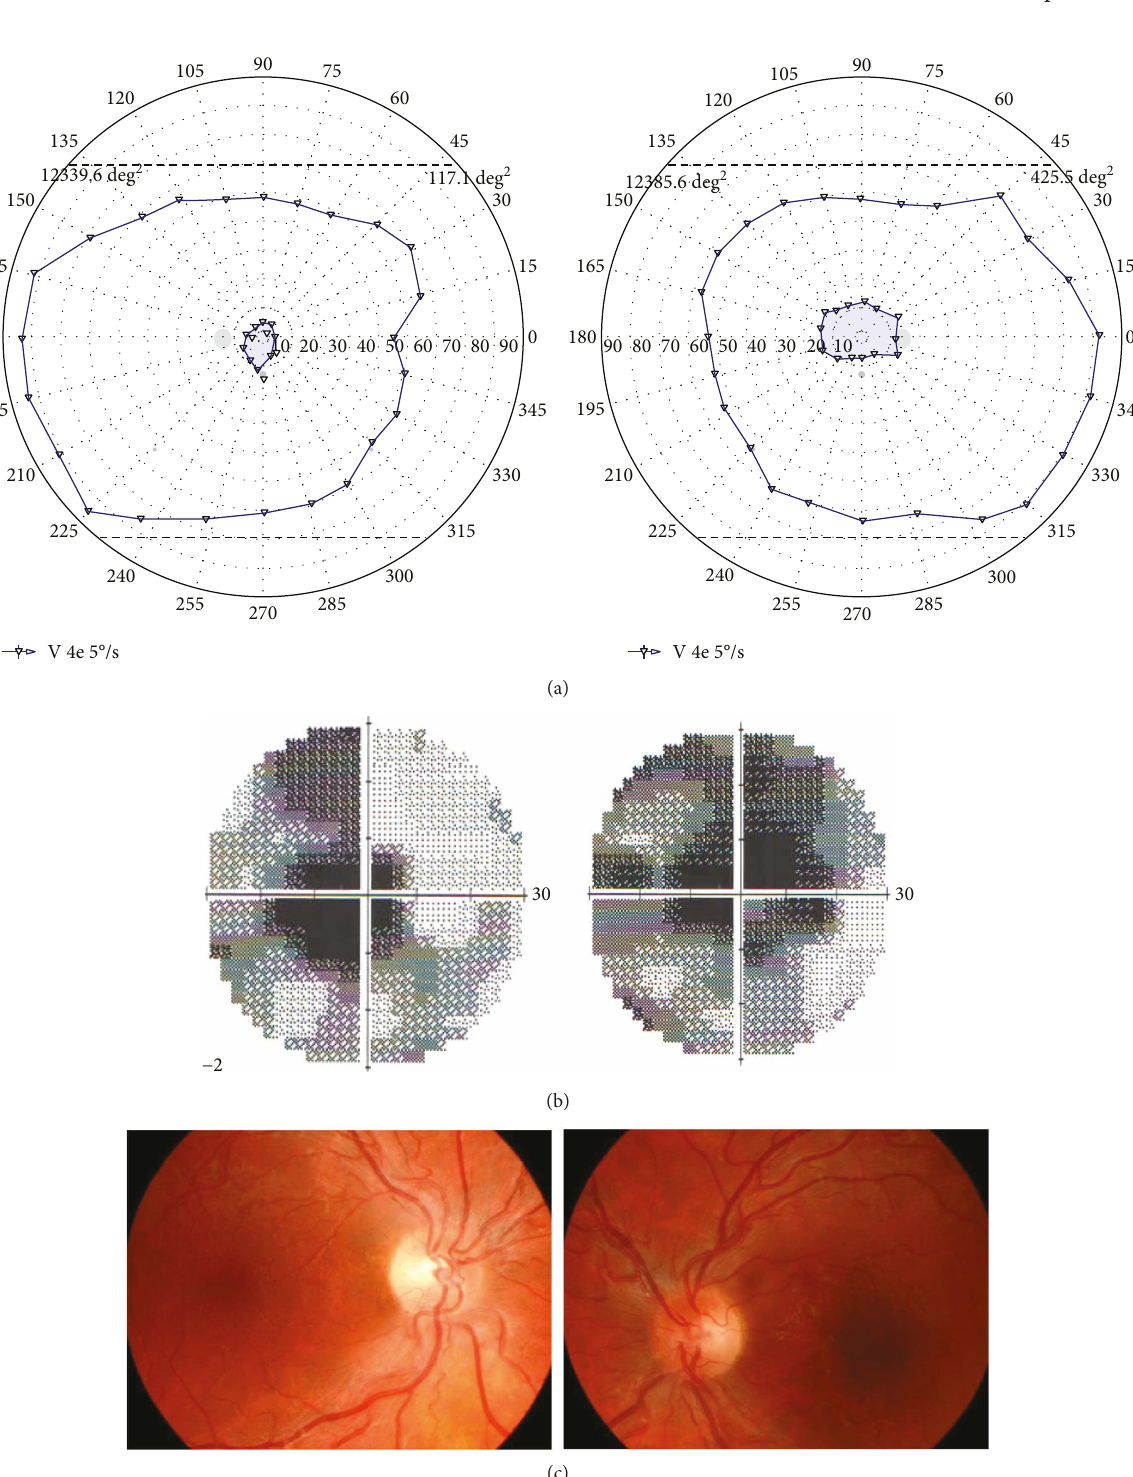
Figure 1: Illustrative case of LHON patient with central scotoma. (a) VF results of both eyes (right eye on the right and left eye on the left) obtained with semiautomated kinetic perimetry and V4e stimulus moved with the speed of 5 degrees per second in patient with LHON. Visual acuity was counting fi ngers to 2 meters in both eyes. Central scotoma and peripheral residual VF measured in square degrees (deg 2 ). (b) VF results of both eyes (right eye on the right and left eye on the left) obtained with static automated perimetry in patient number with LHON. (c) Fundus pictures (right eye on the left and left eye on the right) of patient number 8 showing swelling of the retinal nerve fi bers involving the superior and inferior arcades around the optic disk, as well as retinal vessel